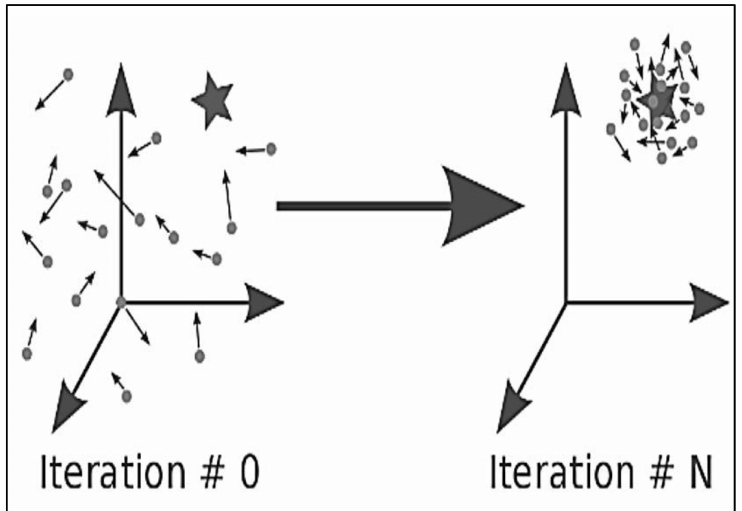
Figure 11. Particle swarm